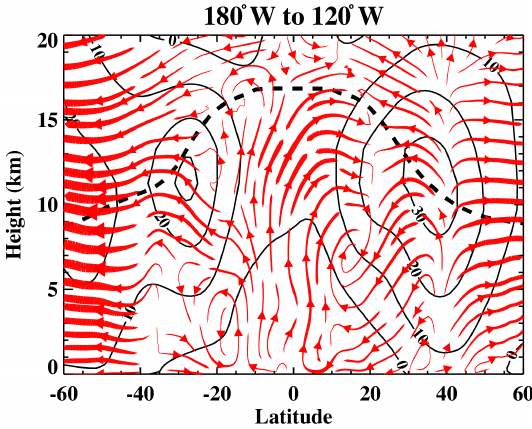
Figure 5. Streamlines of the difference between the mean vertical and meridional winds for months with strong El Niño conditions minus months of strong La Niña conditions from 2005 to 2013. The means are calculated between 180 and 120 ◦ W. The width of the streamlines is proportional to the magnitude of the difference. The dashed line indicates the mean tropopause pressure for strong El Niño months. Solid contours are the zonal mean wind for strong El Niño months.